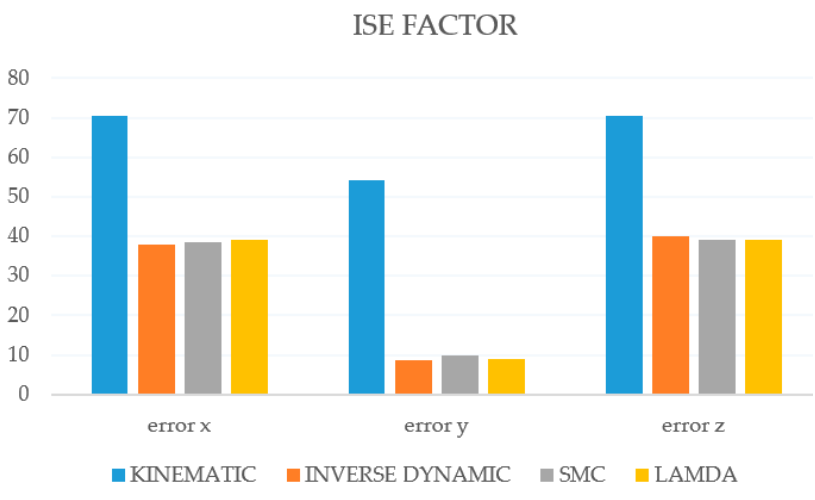
Figure 18. ISE factor for the different control techniques used in the